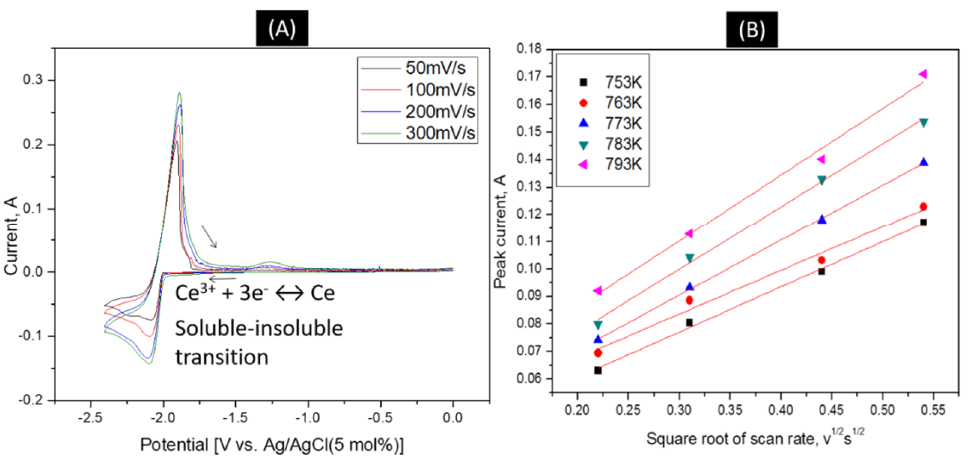
Figure 2. ( A ) Cyclic voltammogram of 4 wt% Ce 3 + / Ce in LiCl-KCl eutectic salt at 773K. ( B ) Dependence of the current versus the square root of the scan rate according to the changing temperature in LiCl-KCl-CeCl 3 (X CeCl3 = 8.626 × 10 − 3